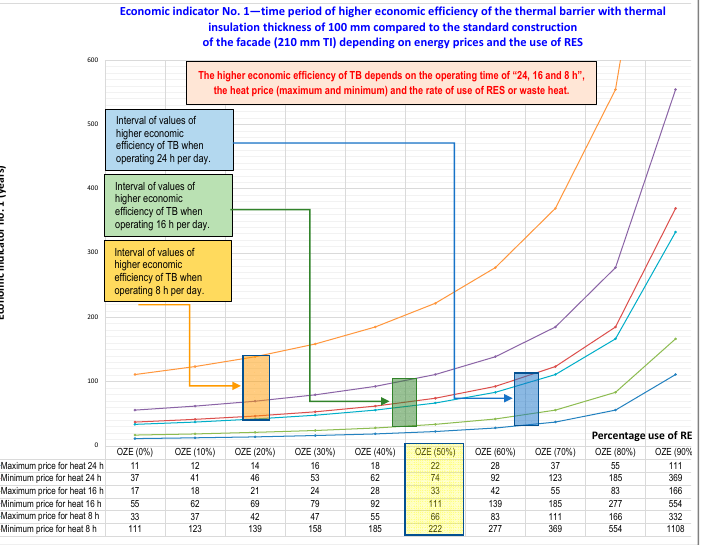
Figure 17. Economic indicator No. 1—time period of higher economic efficiency of the thermal barrier depending on energy prices, thickness of thermal insulation and use of RES.